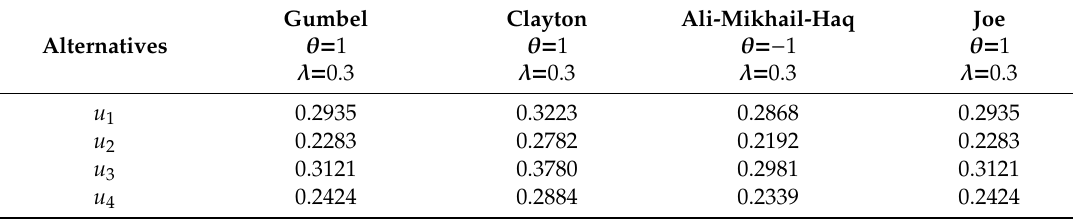
Table 8. The score function’s results using IFACWAA w